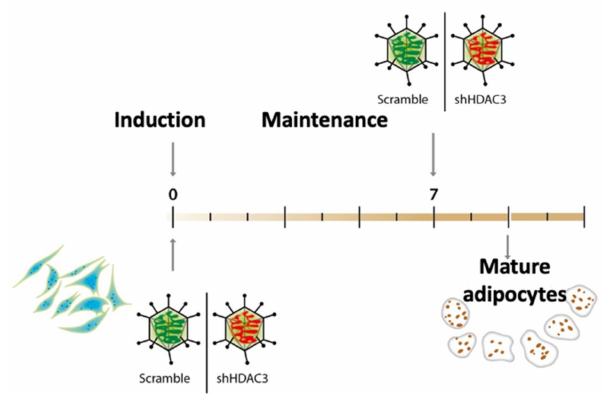
Figure 1. C3H/10T1/2 cells induced to differentiate to adipocytes using a standard hormonal cocktail and maintained until terminally differentiated. HDAC3 was silenced by adenovirus- mediated short hairpin RNA interference at the beginning of differentiation (day 0) or at the end of differentiation (day